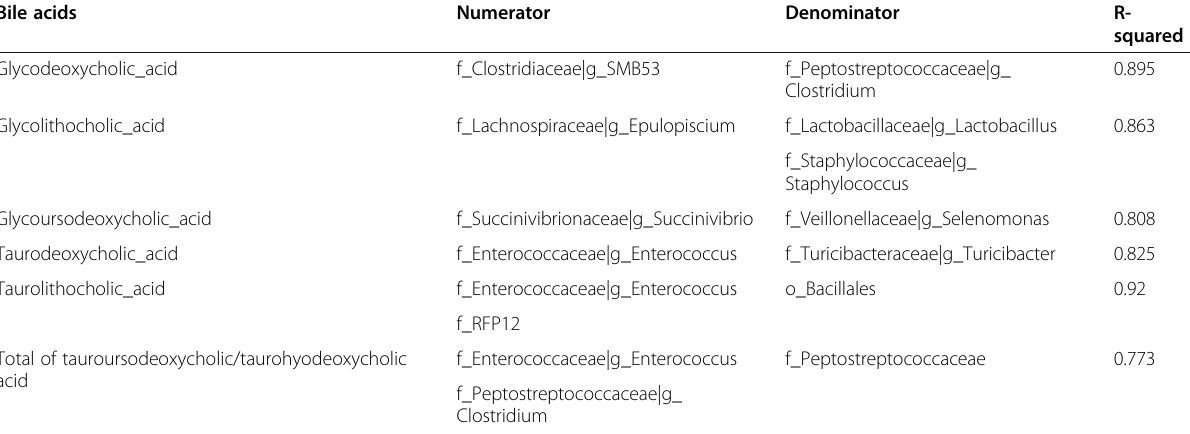
Table 4 Global balances in jejunal bacterial communities highly predictive for secondary bile acids Bile